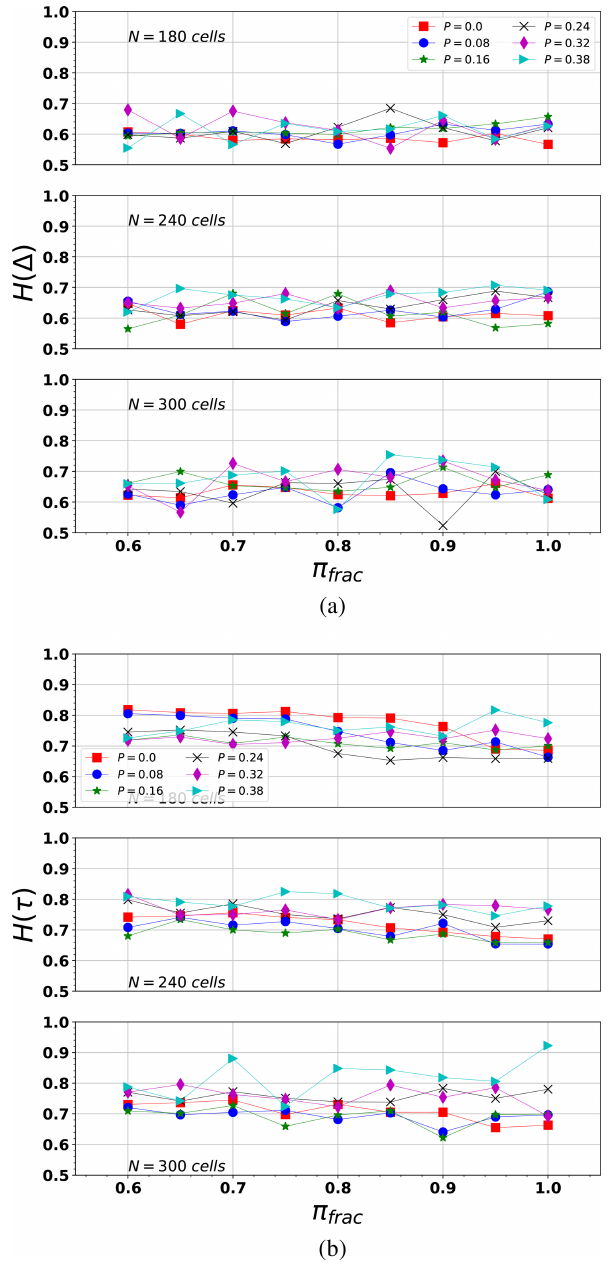
Figure 9. Hurst exponent values (a) H((cid:49)) and (b) H(τ) computed for different synthetic series considering three input parameters ( N , P , π frac ). From top to bottom, N = 180, N = 240, and N = 300 (cells per lateral size in the